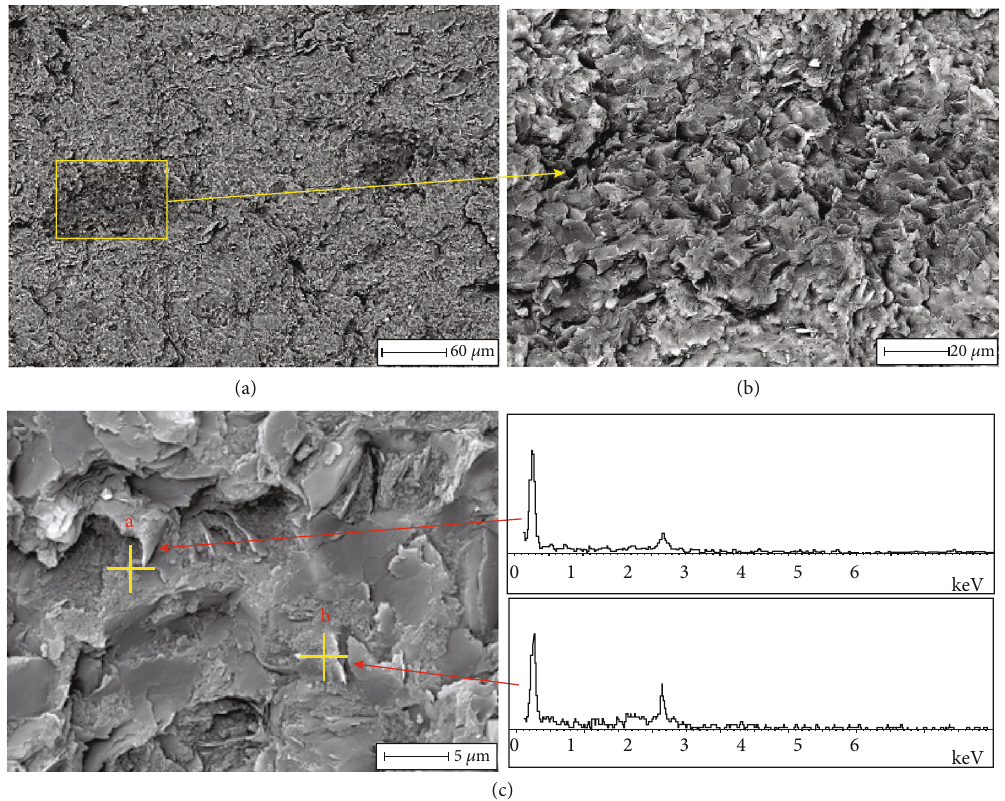
Figure 6: Algae morphological photograph and energy spectrum of the Wufeng-Longmaxi Formation shale in the southeast Sichuan Basin. (a) The dark part is algae. (b) Ampli fi cation of (a). (c) Ampli fi cation of (b). The algae are mainly carbonaceous and energy spectrum